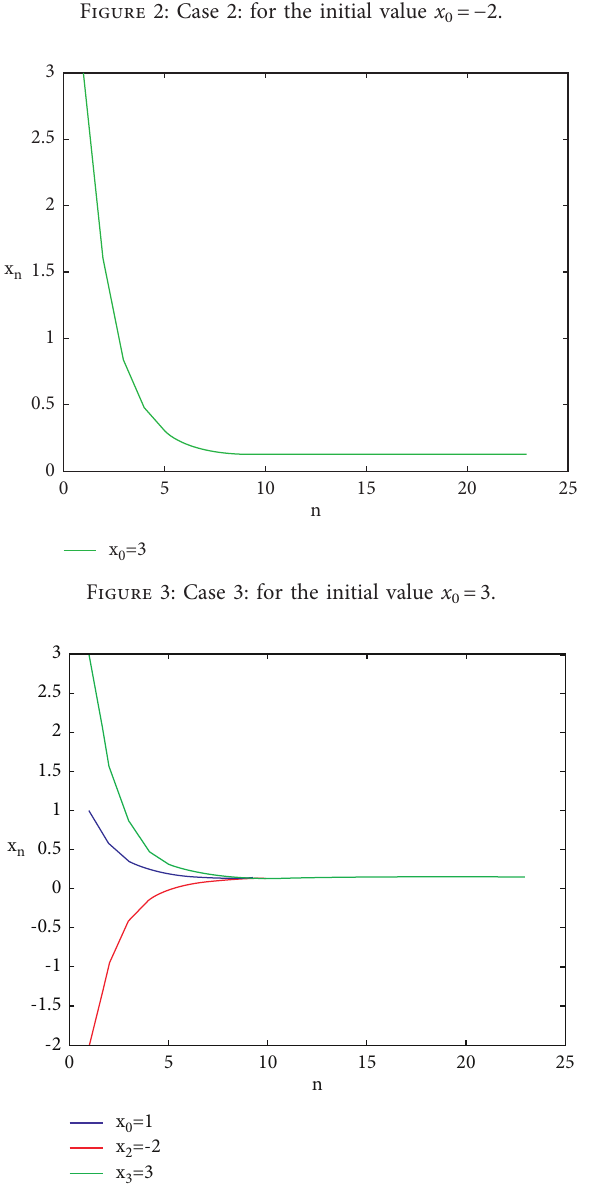
Figure 2: Case 2: for the initial value x